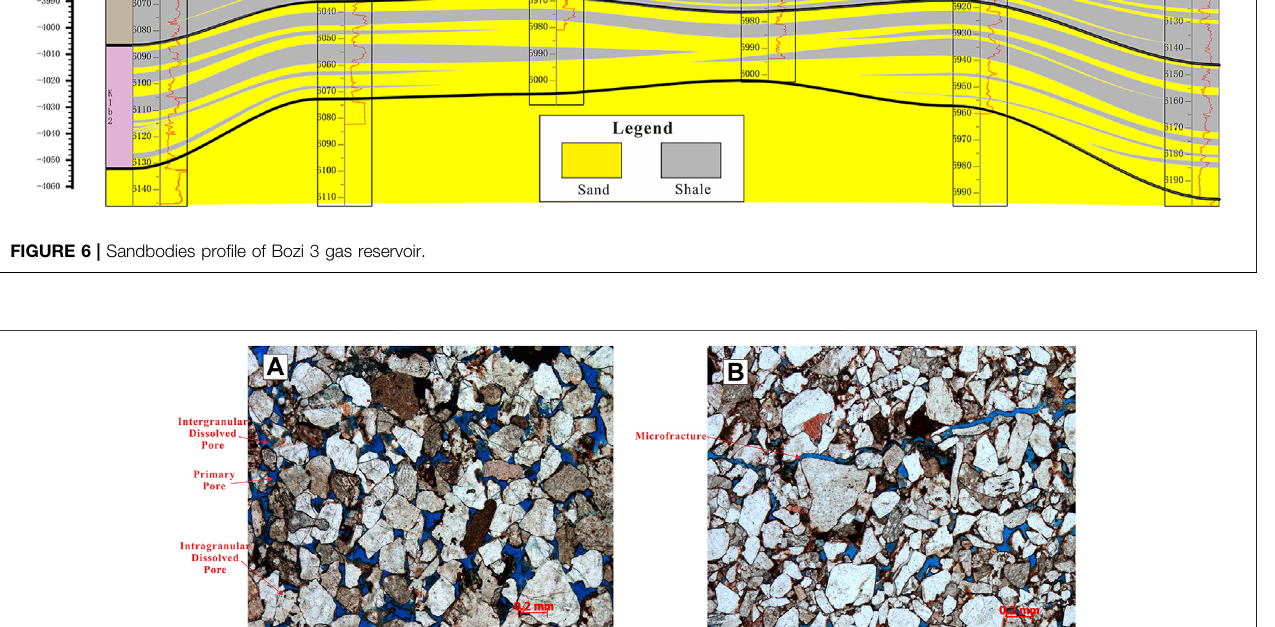
Frontiers in Earth Science |